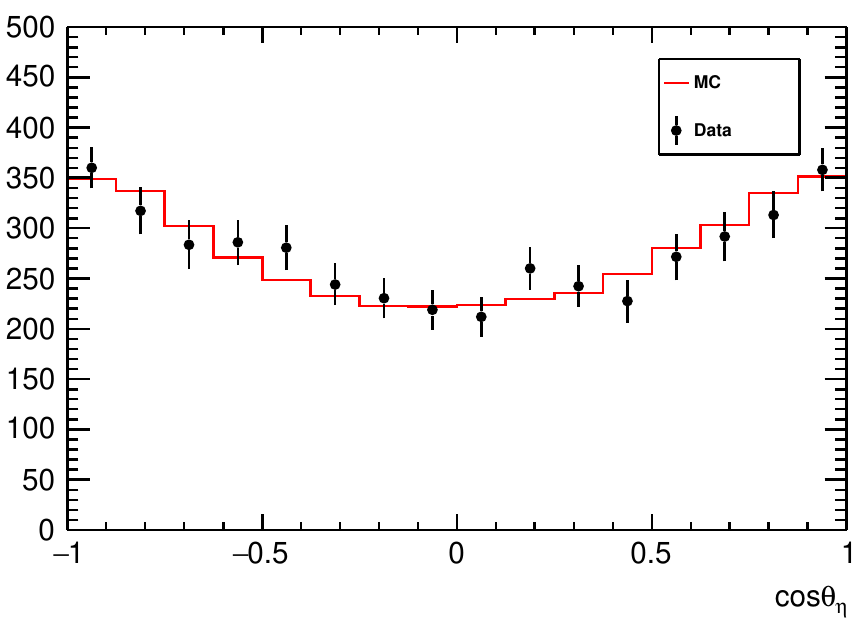
p s = 1 : 3{1 : 8 GeV. Simulation uses a model